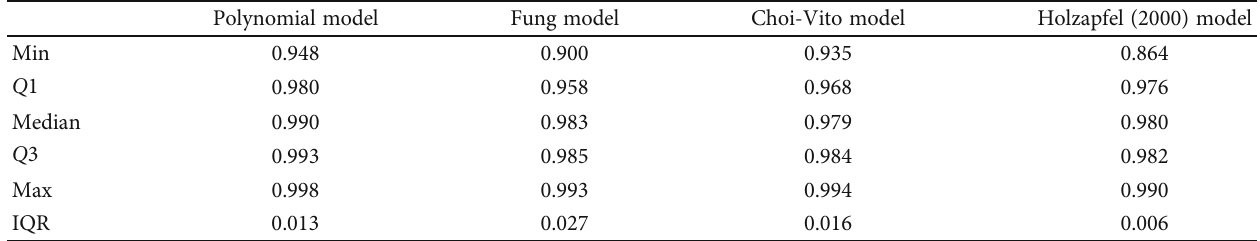
Table 6: Fitting of hyperelastic models ( N = 15 ) showing box plot properties of the coe ffi cient of determination ( R 2 ) with Q 1 , median, and Q 3